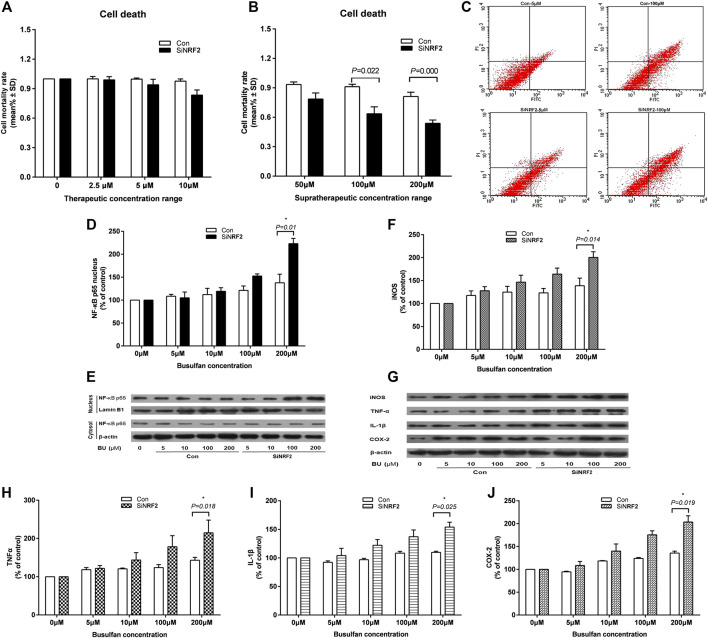
High exposure of endothelial cell to BU induced a proinflammatory response mediated by NF-κB and the toxicity in the absence of Nrf2. Death (A and B) and apoptosis (C) of human vascular endothelial cells (EA. hy 926) transfected with NRF2 specific siRNA (siNRF2) or not (Control) exposed to therapeutic or supratherapeutic BU concentrations. Western blot analysis of NF-κB (D and E), iNOS, TNF-α, IL-1β, and COX-2 (F and G, H, I, J) proteins levels in EA. hy 926 cells exposed to increasing BU concentrations.